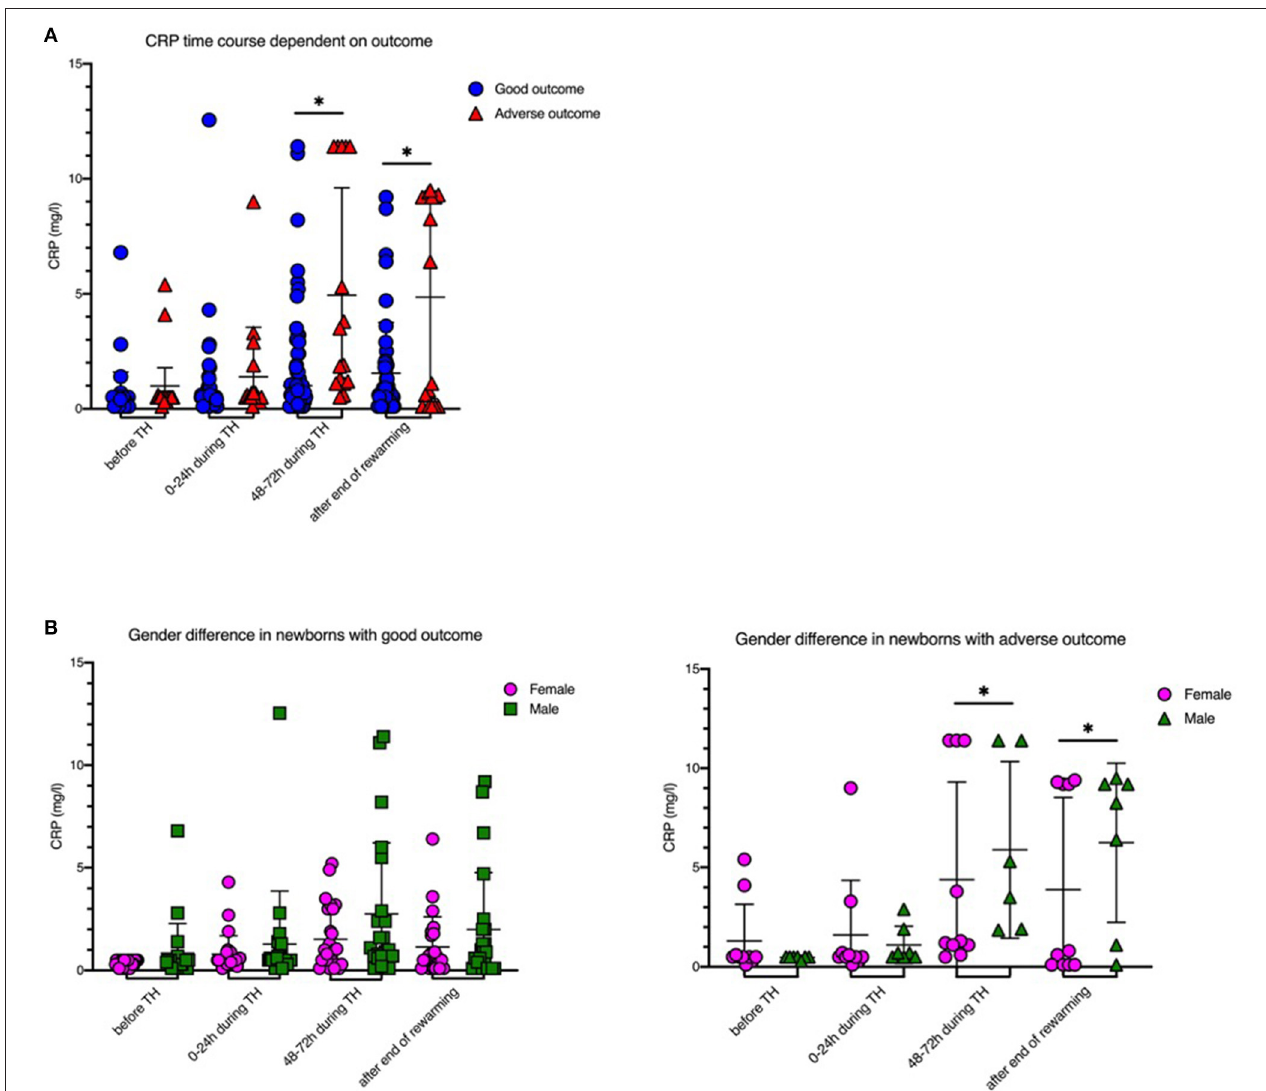
FIGURE 2 | CRP levels before, during and after therapeutic hypothermia. (A) CRP levels were higher in newborns with death or adverse MRI findings, defined as BG/W score > 2. (B) Males had increased CRP values compared to females. Males with death or adverse MRI findings had significantly increased CRP values at the end of the cooling phase and after rewarming. Data presented as mean ± standard deviation (SD), * p < 0.05.